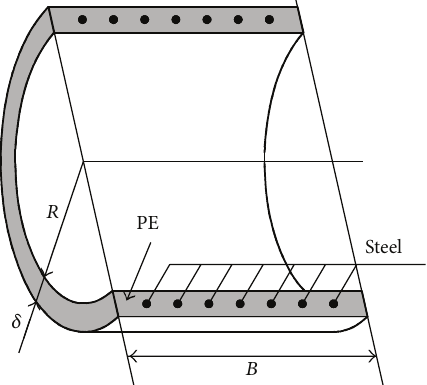
Figure 2: Schematic of a steel-mesh-reinforced PE